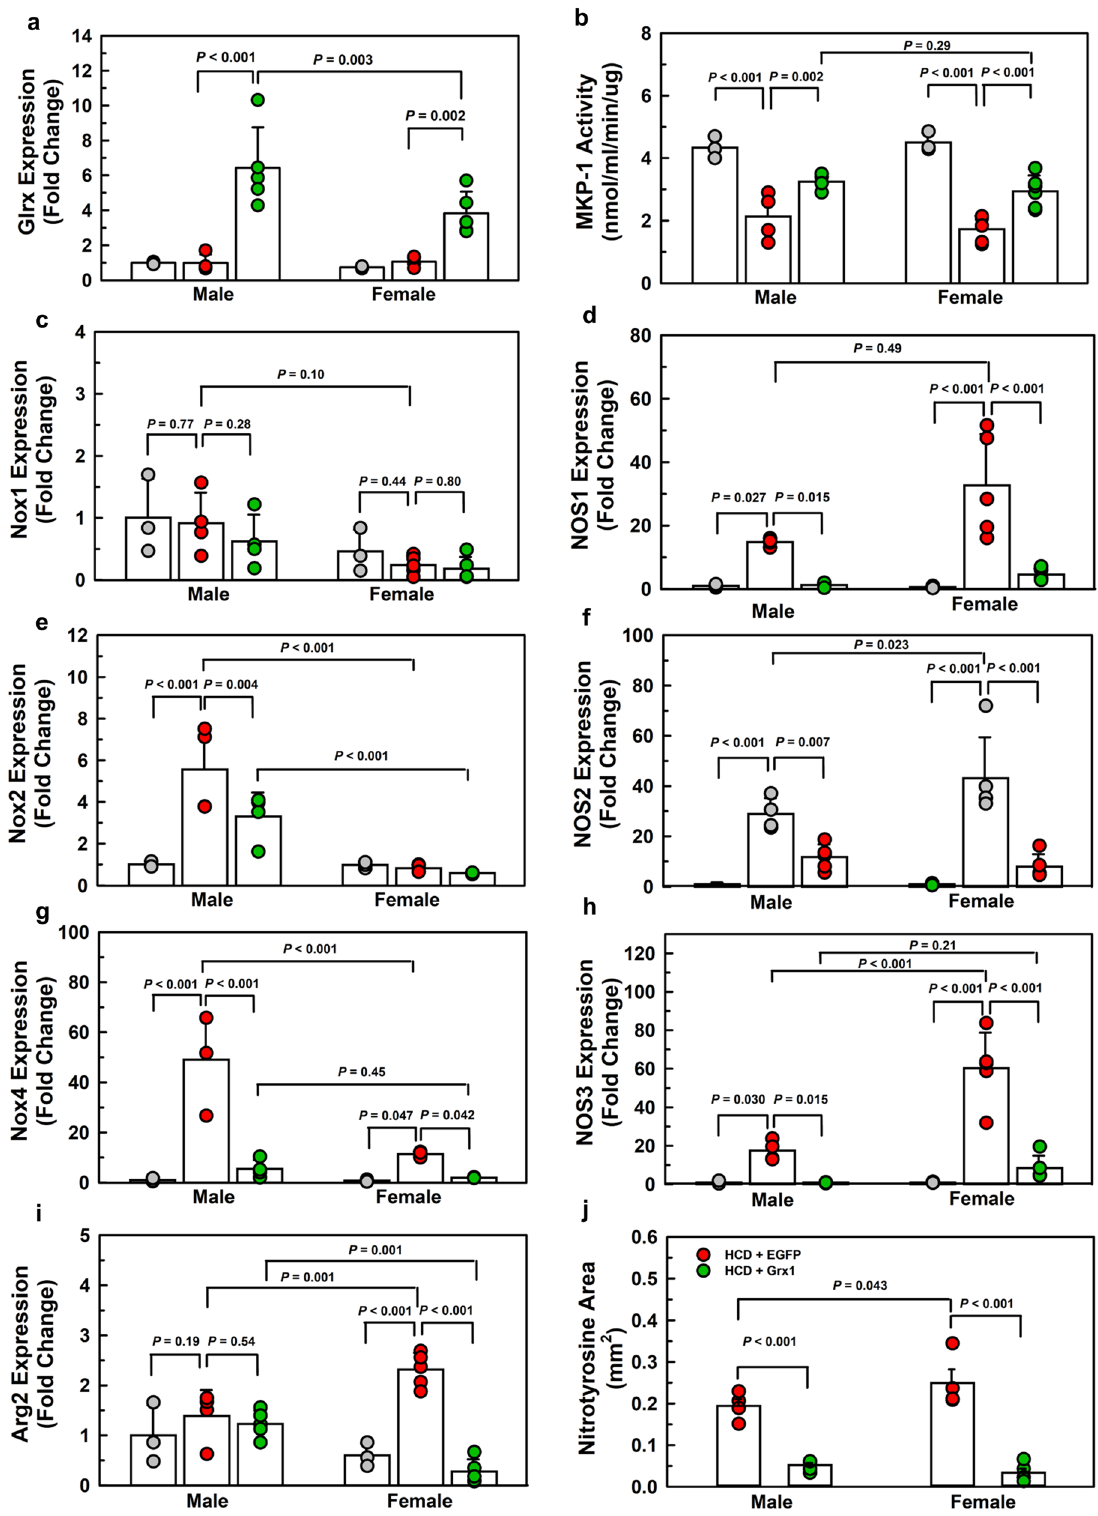
at a concentration of 5 ×10 5 cells/100 μ l. BM recipient mice were randomized into two groups (EGFP Mac tg : n = 9; Grx1 Mac tg : n = 10) and were injected with virus- transduced cells of the corresponding sex via the retro-orbital sinus. Animals reconstituted with cells expressing CD68-EGFP were designated as EGFP Mac tg and those that received CD68-Grx1-IRES-EGFP as Grx1 Mac tg . Irradiation and bone marrow transplantation . BM transplantations (BMT) were conducted as described previously 45 . Brie fl y, two weeks before irradiation and